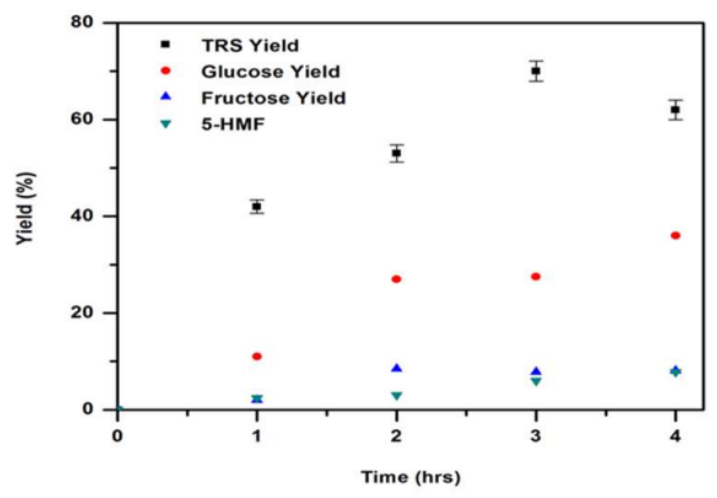
Figure 5. Effect of hydrolysis time on the yield of TRS (temperature 180 °C, catalyst-to-substrate ratio of 2:1 ( w / w )) . of 2:1 ( w / w